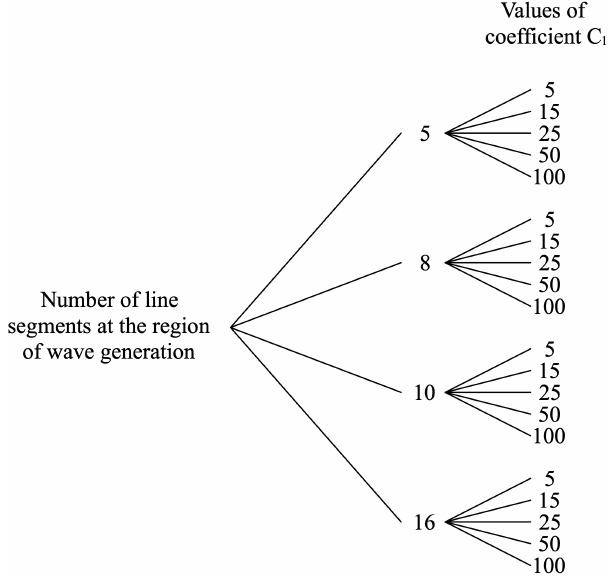
Figure 4. Number of line segments at the region of wave generation and values of coefficient C 1 used in the mesh independence study. Table 1. Length and height of mesh elements used in the mesh independence study.